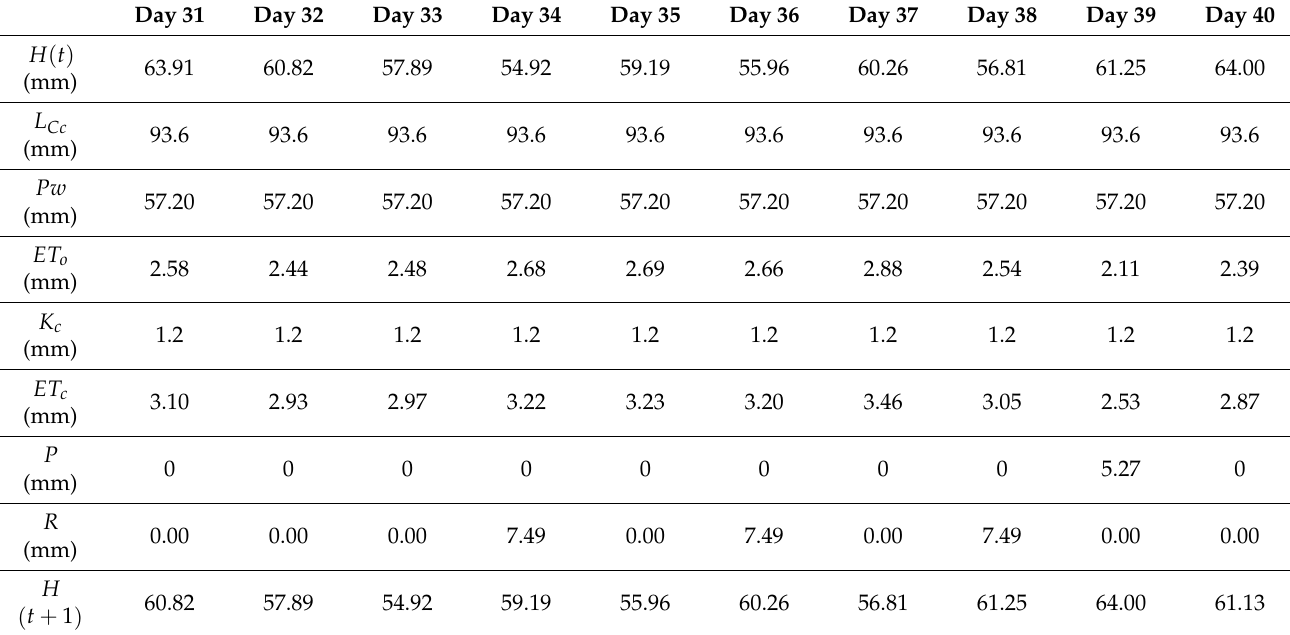
Table 6. Irrigation schedule for 10 days at the intermediate